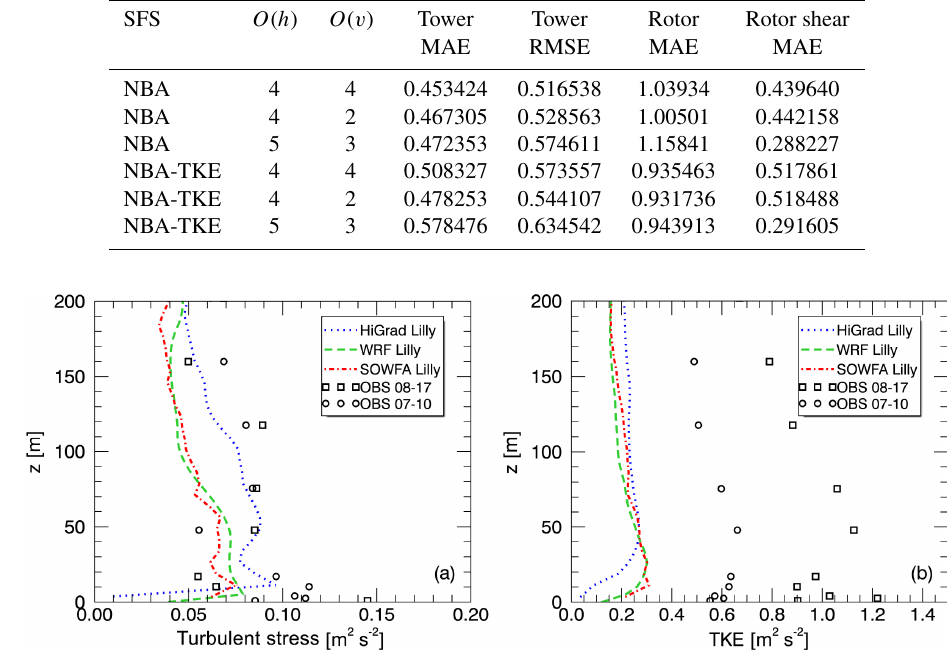
Figure 11. Simulated and measured turbulent stress (a) and TKE (b) , from the neutral case study.